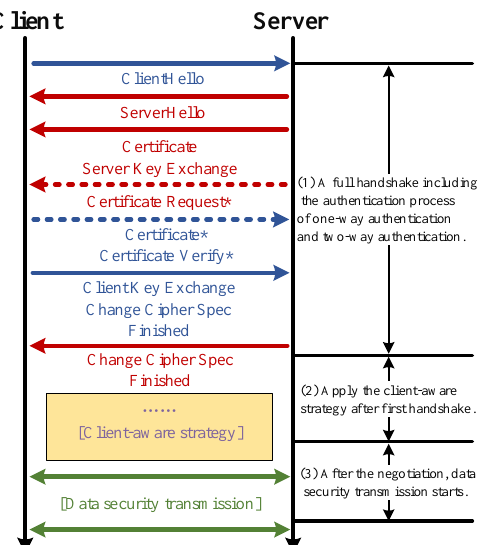
Figure 1. A flow diagram of client-aware secure data transmission methods. The messages with ‘*’ are for two-way